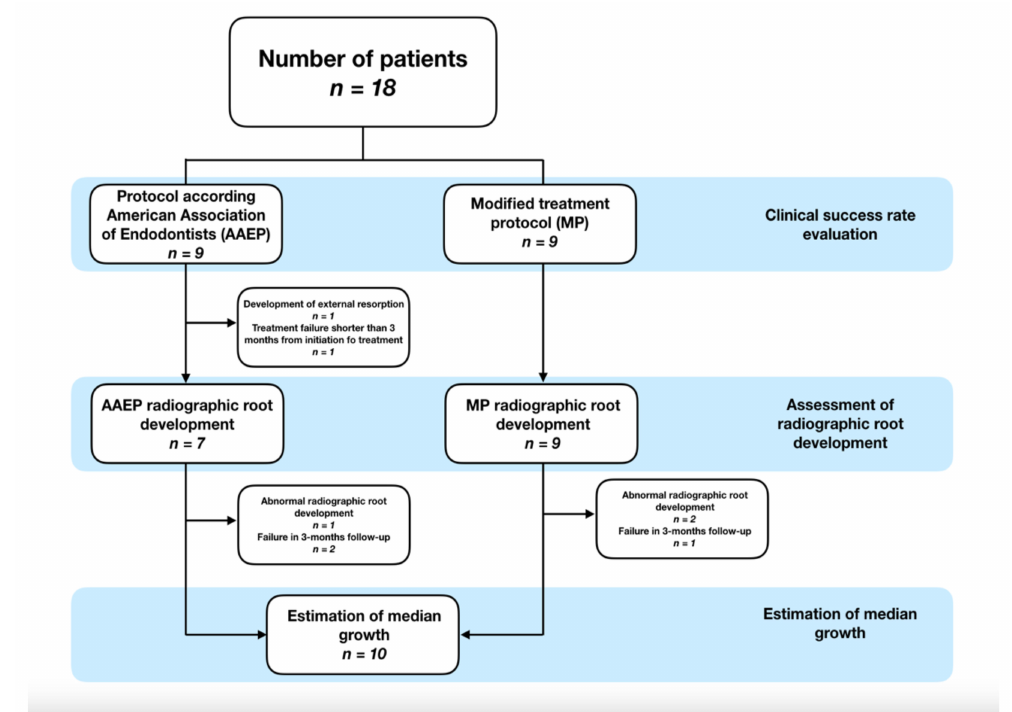
Figure 1. Flow chart of patient